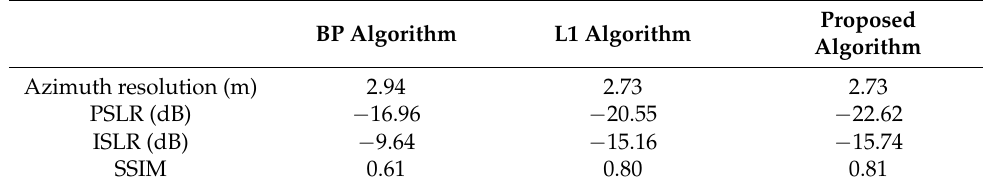
Table 5. Evaluation